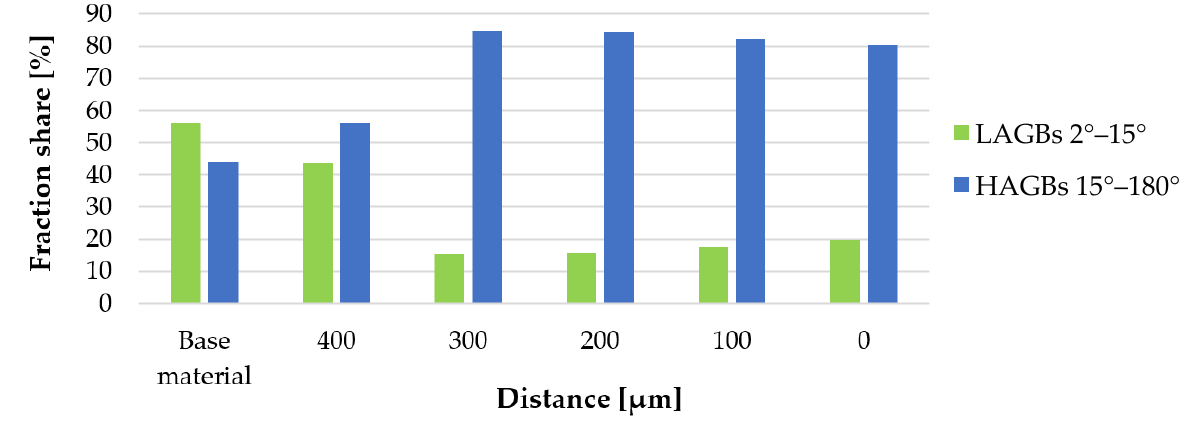
Figure 12. Share of low- and high-angle grain boundary fractions in the measurement areas.